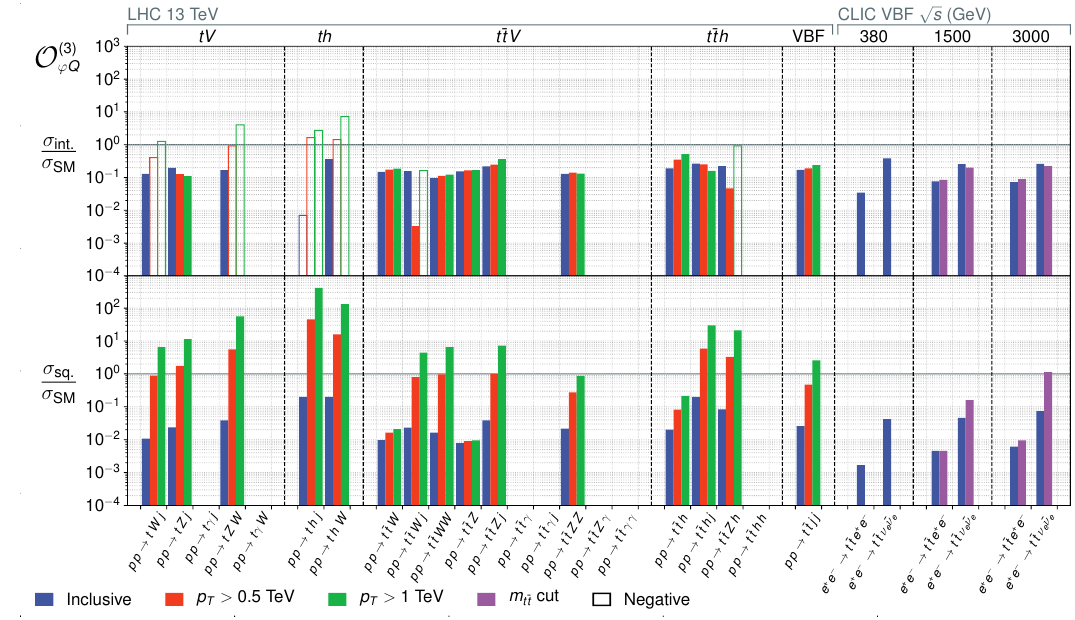
(3) assuming a Wilson coef- ’Q O